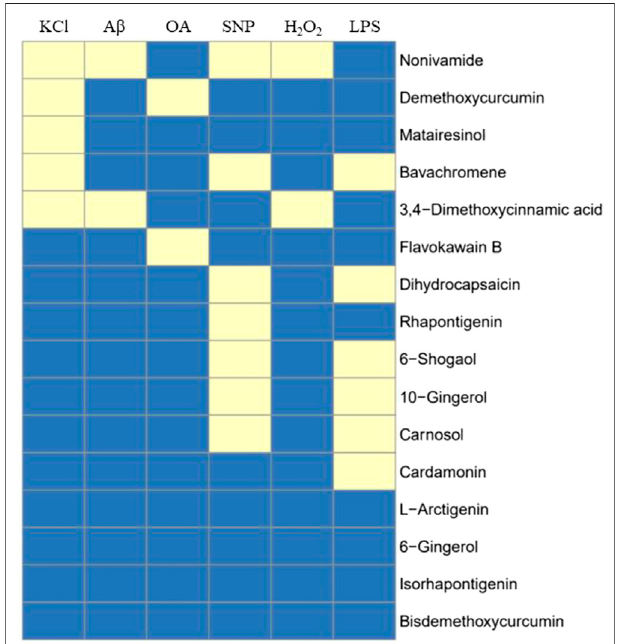
FIGURE 14 | Summary of 16 compound ’ s activity on 6 cell models. 16 compounds were tested against all cell systems established in this study, including KCl, A β , OA, SNP, H 2 O 2 -induced SH-SY5Y cell models and LPS- inducedBV2model,and12outof16compoundsshowedactivityinone or more cell models, indicating potential anti-AD activity. Yellow means